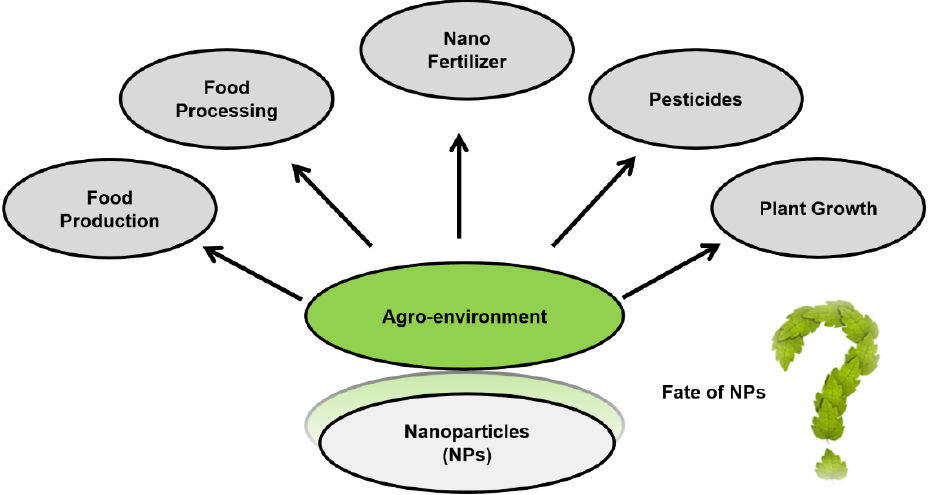
Figure 3. Applications of NPs in agro-environments.